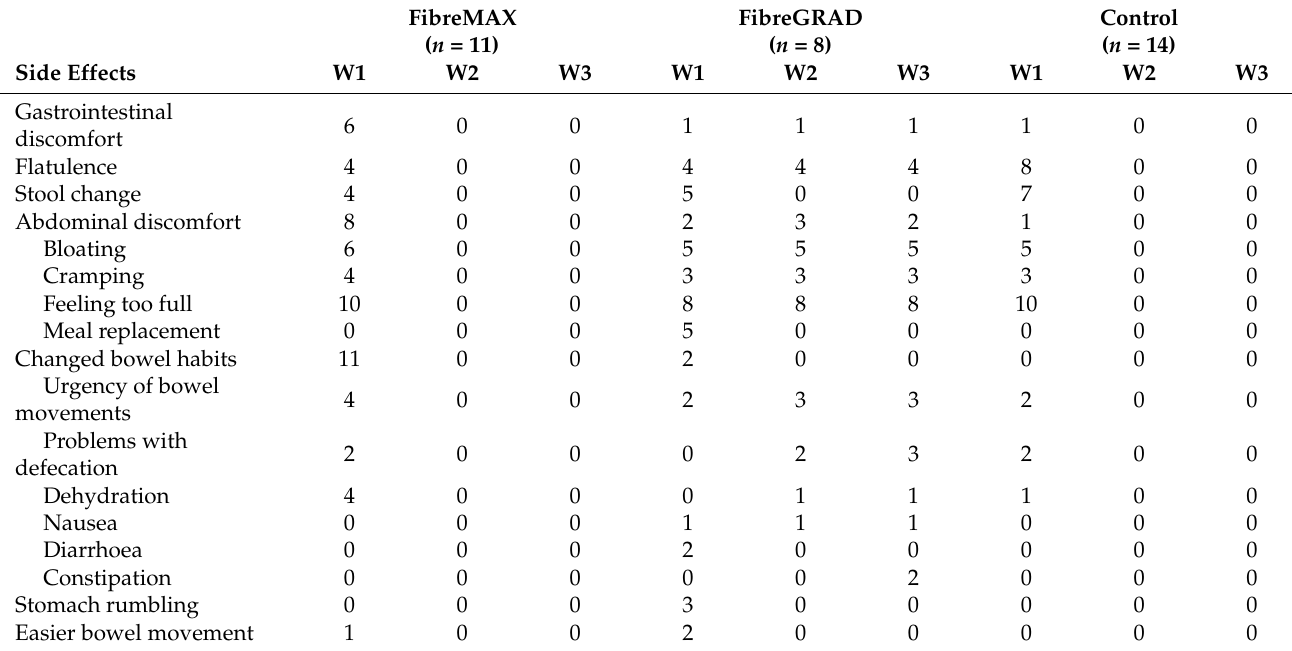
Table 3. Frequency of reported side effects for each condition per week.